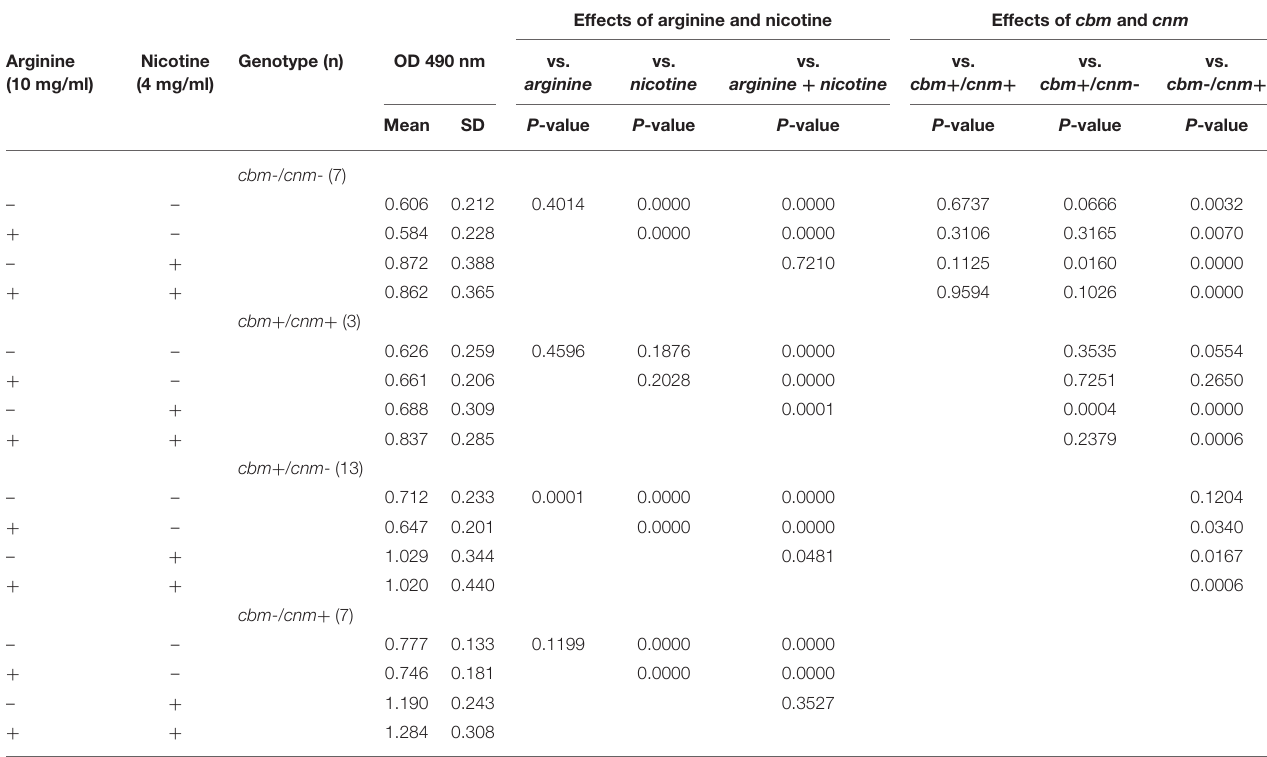
TABLE 2 | The effects of S. mutans CBP genotype on biofilm mass measured by crystal violet in response to arginine (10 mg/ml) and nicotine (4 mg/ml).